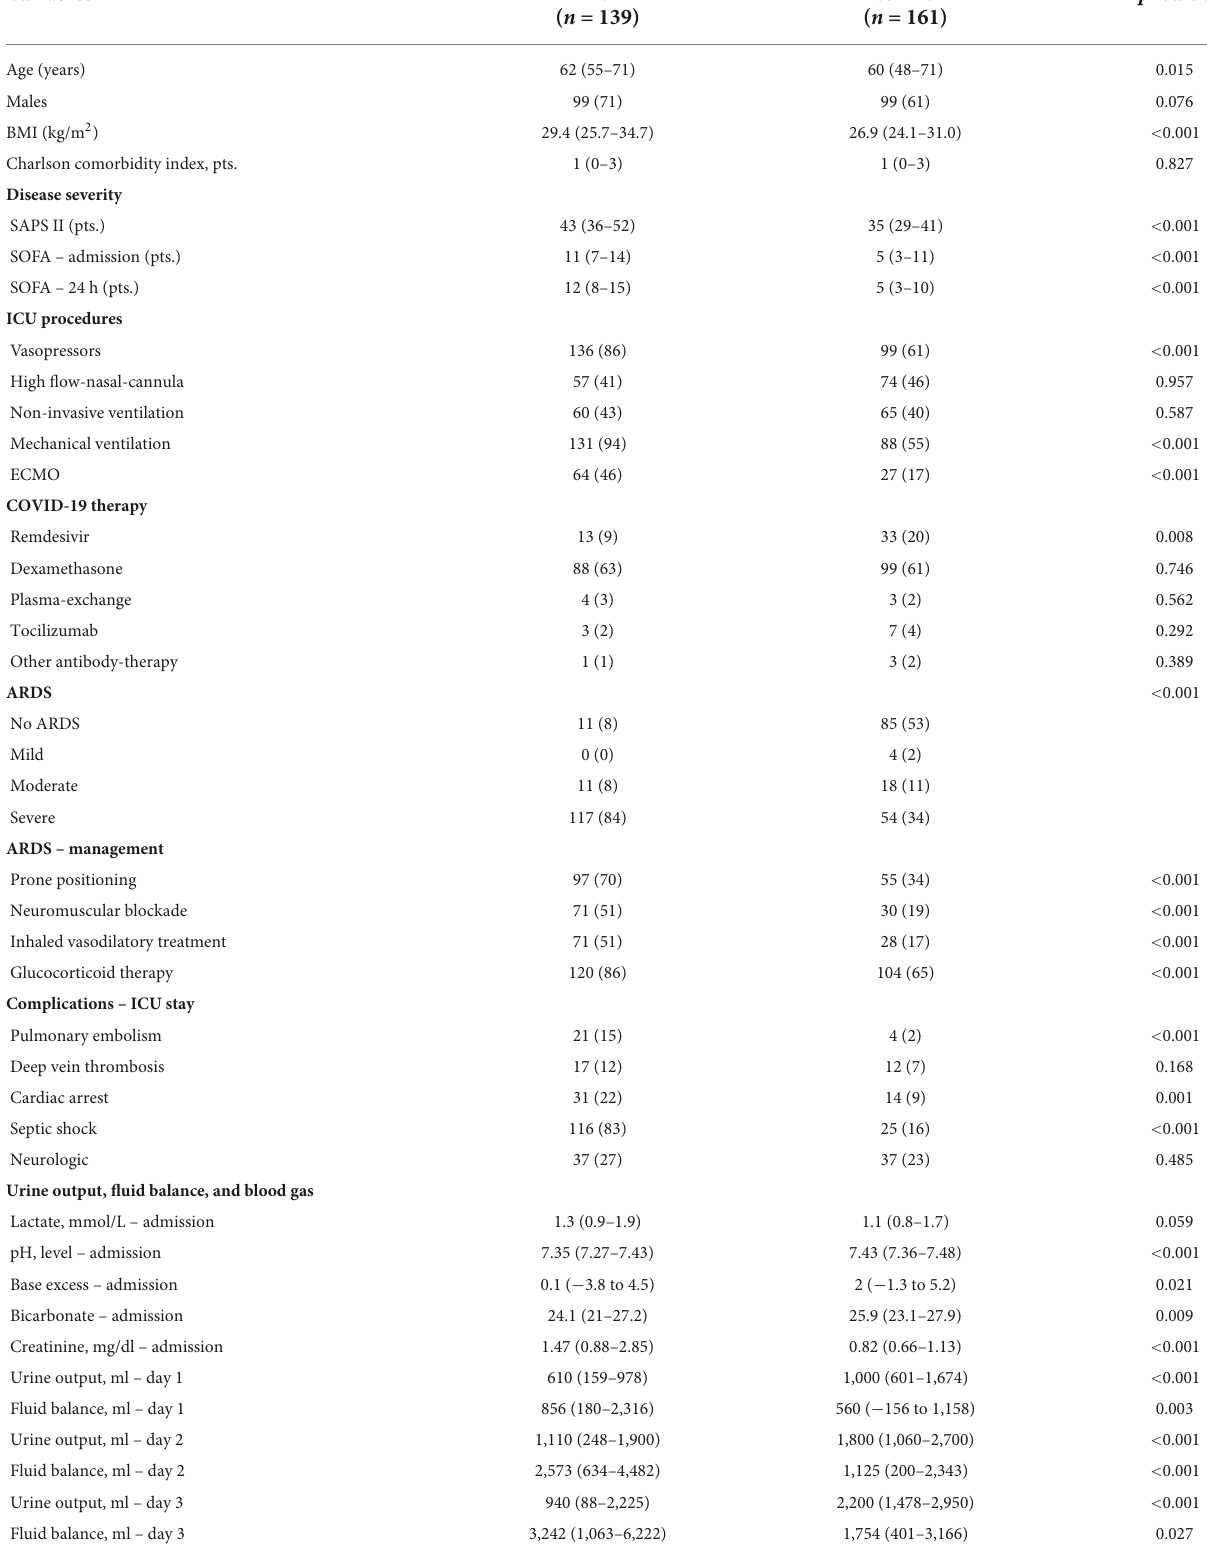
TABLE 3 Demographic and clinical characteristics of patients with and without kidney replacement